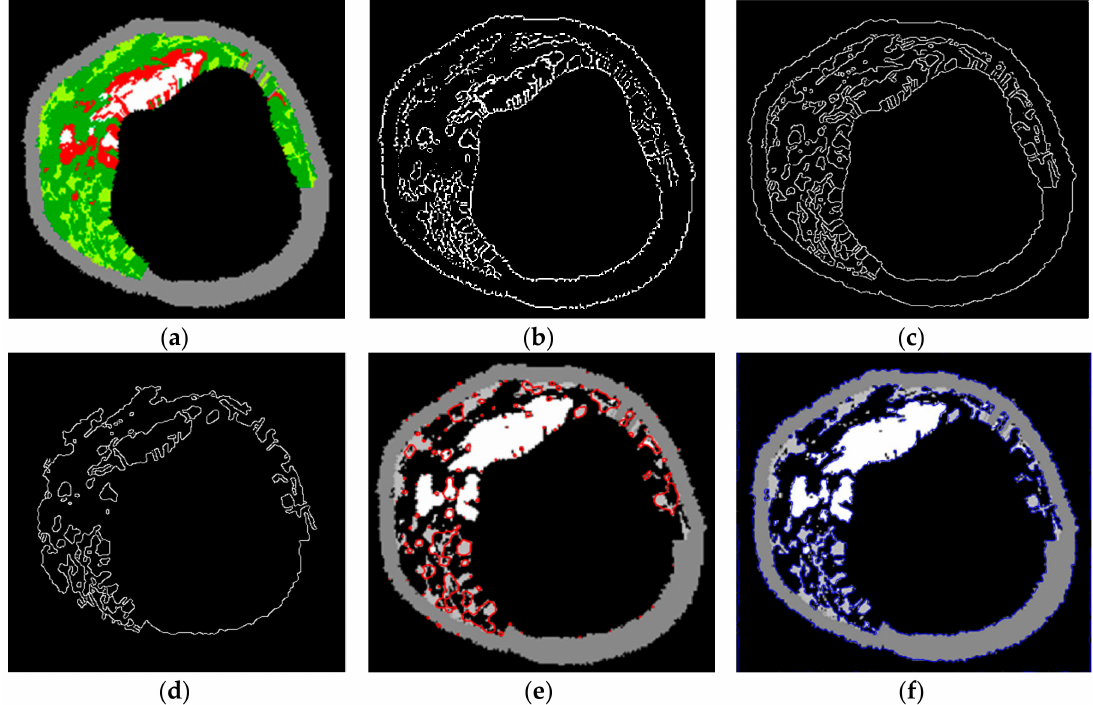
Figure 2. ( a ) VH-IVUS image, ( b ) thresholding, ( c ) edge detection, ( d ) region growing, ( e ) level set, and ( f ) active contour